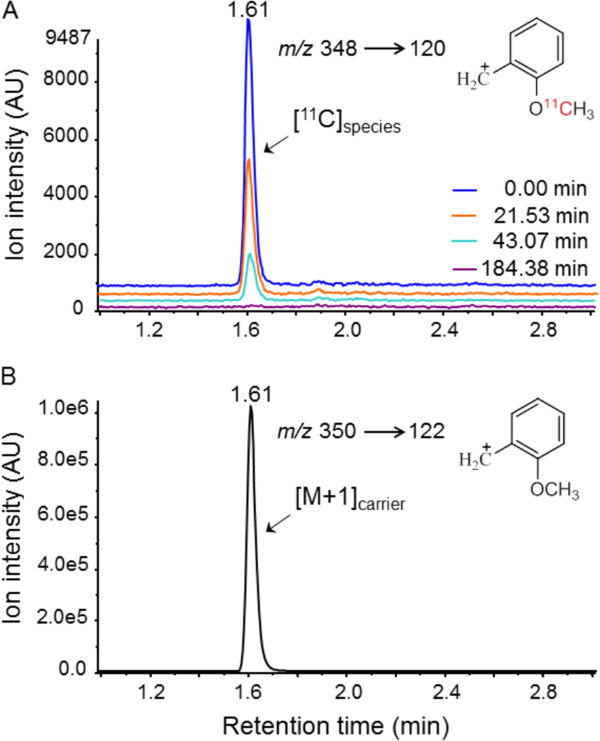
LC-MS/MS of the same [11C]PBR28 preparation at four time-points of carbon-11 decay. The ion chromatogram overlay showing peaks for [11C]species as it decayed (A) and unchanging peak for [M + 1]carrier (B) during the same analysis. Their respective product ions m/z 120 and 122 were monitored.